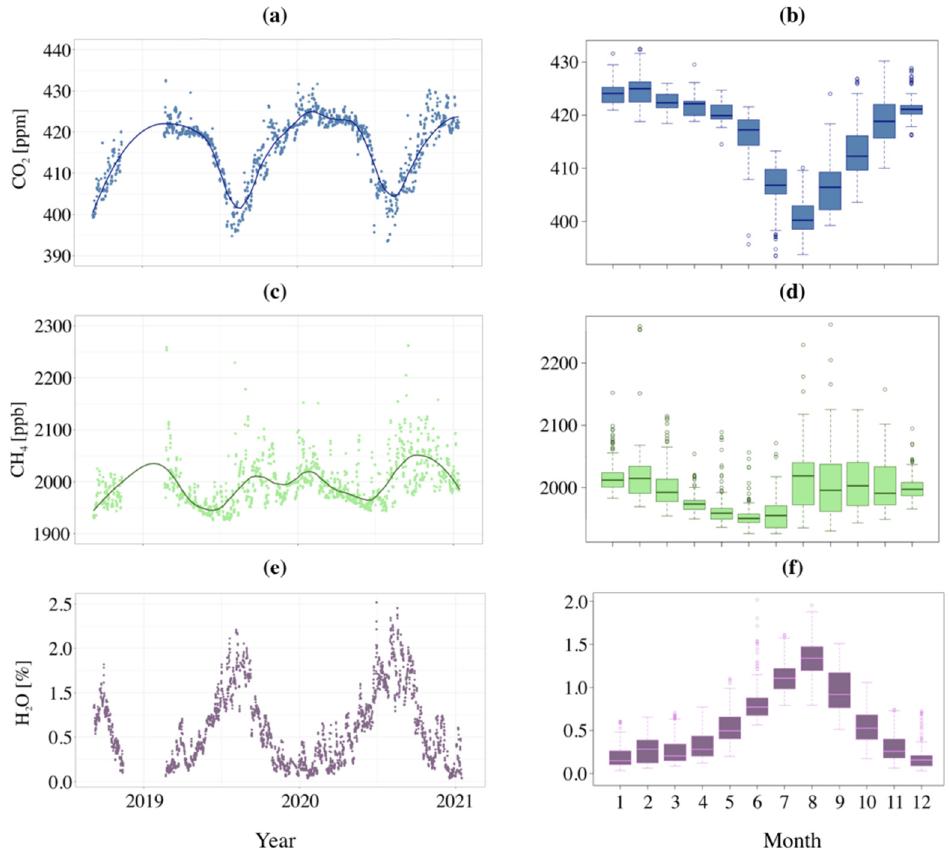
Figure 5. Seasonal dynamic and monthly median values of CO 2 ( a , b ), CH 4 ( c , d ), and H 2 O ( e , f ) at the measurement station “DIAMIS” for the period of observations (09.2018–01.2021). For CO 2 and CH 4 , the afternoon data records (1–4 pm LT) and fitting curves are given. For each box, the central line illustrates the median, the bars indicate the lower ‘hinge’ and the upper ‘hinge’ and the extremes of the upper and lower whiskers. Dots indicate outliers.